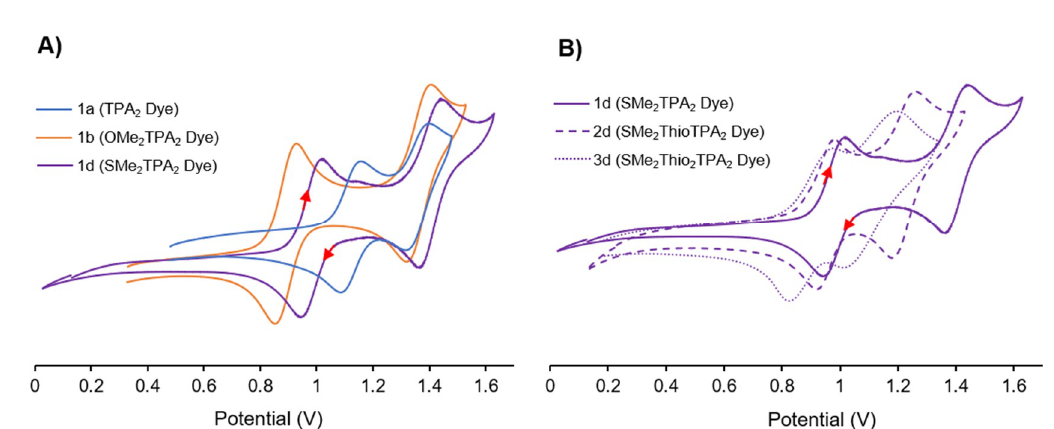
Figure 6. Examining substituent ( A ) and π-spacer effects ( B ) with cyclic voltammetry (DCM, 100 mV/s, 0.1 M NBu 4 PF 6 ). A) In 1b the strong donating effects of -OMe destabilize the HOMO of the distal TPA compared to 1a or 1d , while only modestly affecting the second oxidation potential. B) Contrasts the inclusion of additional π-spacers 1d (none), 2d (one), 3d (two). While only modest changes are observed in the distal TPA oxidation potential, the inclusion of additional thiophene π- spacers more dramatically decreases the second oxidation potential.